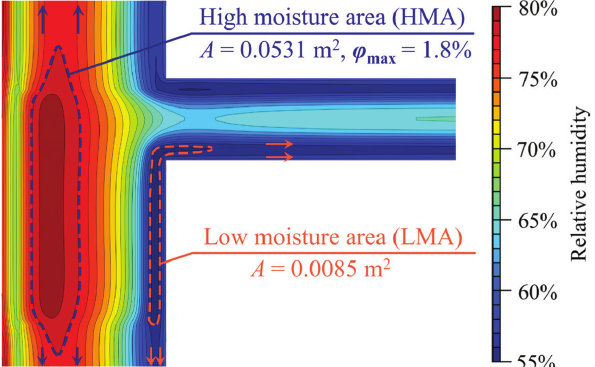
Illustration of the HMA and LMA in the insulated WFTB (the distribution of ϕ at 6057